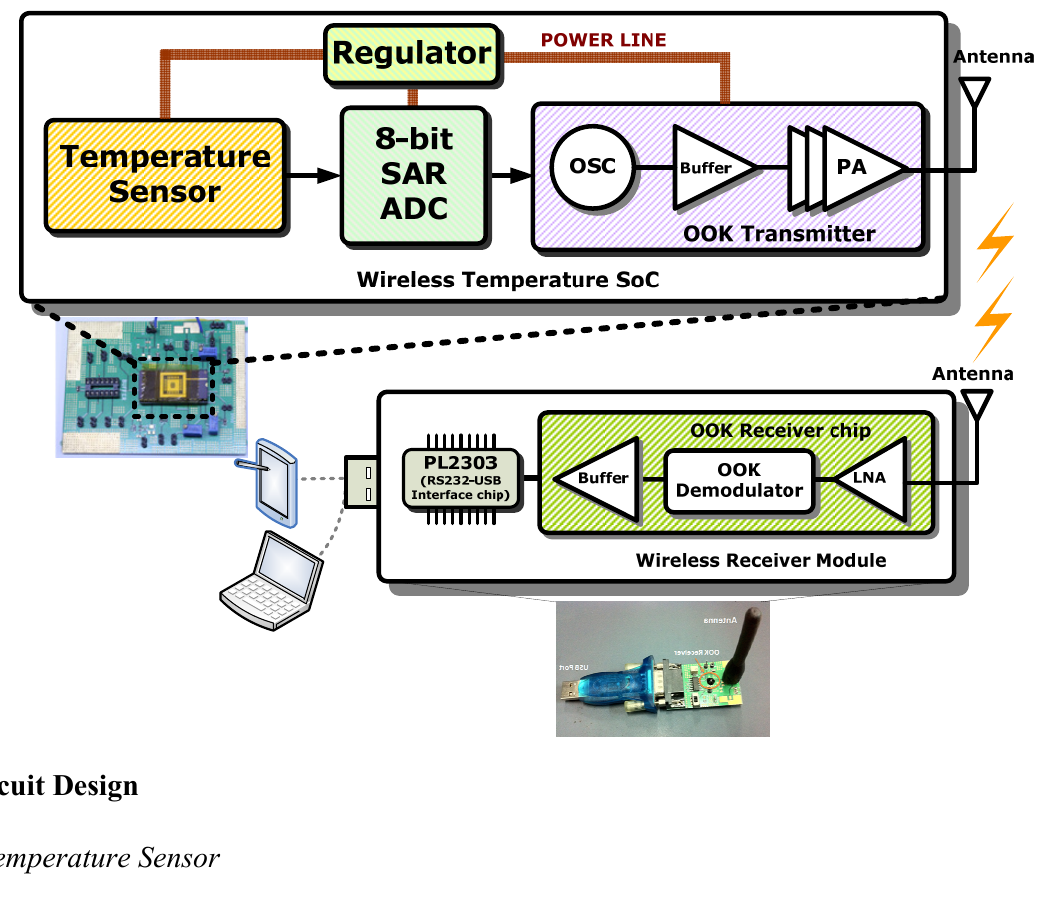
Figure 1. Block diagram of the proposed